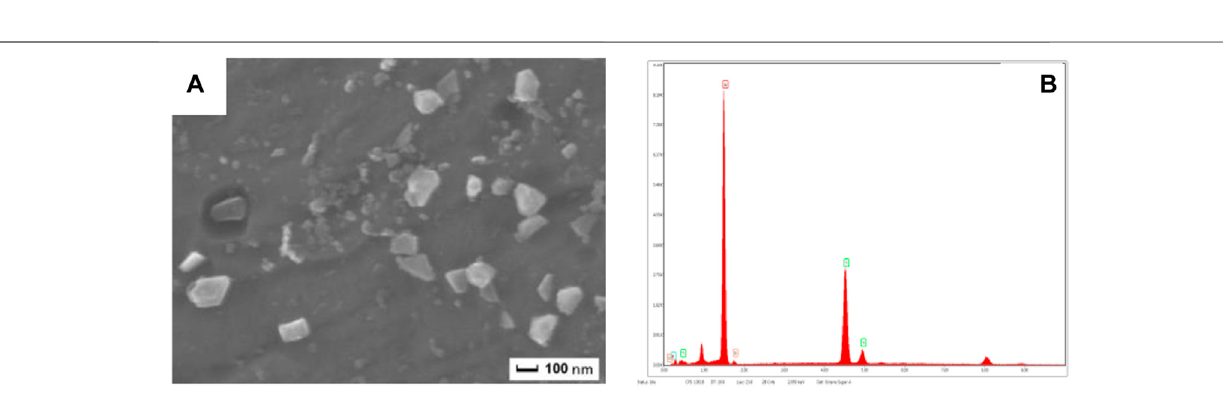
FIGURE 3 | SEM micrograph (A) and EDS spectrum (B) of specimen with 1% TiB 2 particles.